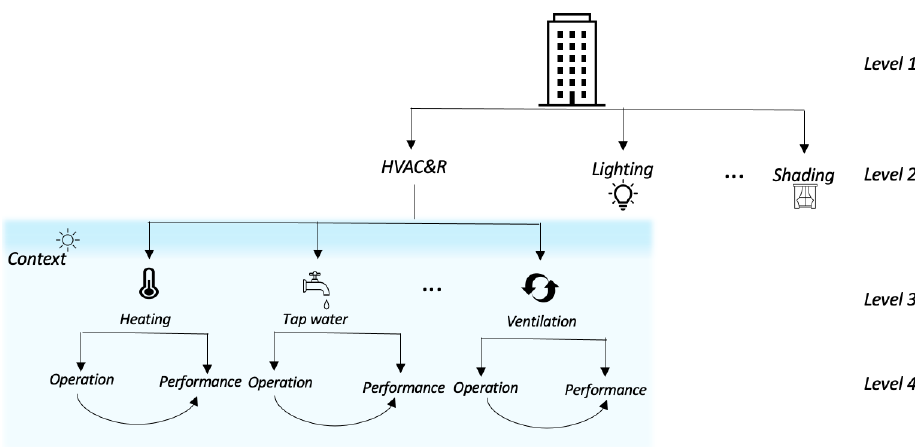
Figure 2. Example of integrated systems in a smart